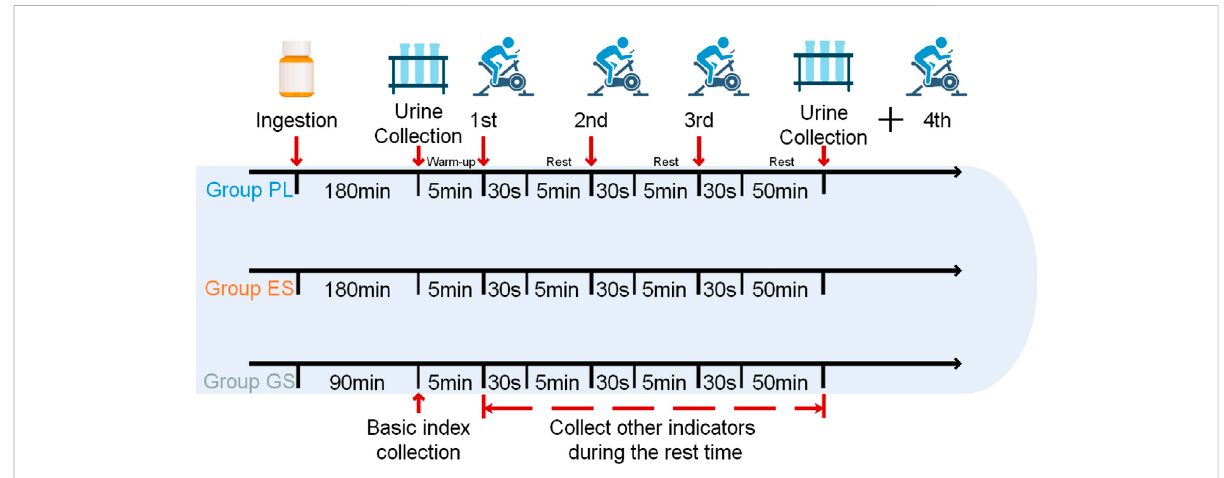
FIGURE 1 Main procedure of the trials. placebo (PL), enteric-coated sodium bicarbonate (ES), general sodium bicarbonate (GS). 1st: the fi rst WACT; second: the second WACT; third: the third WACT; fourth: the fourth